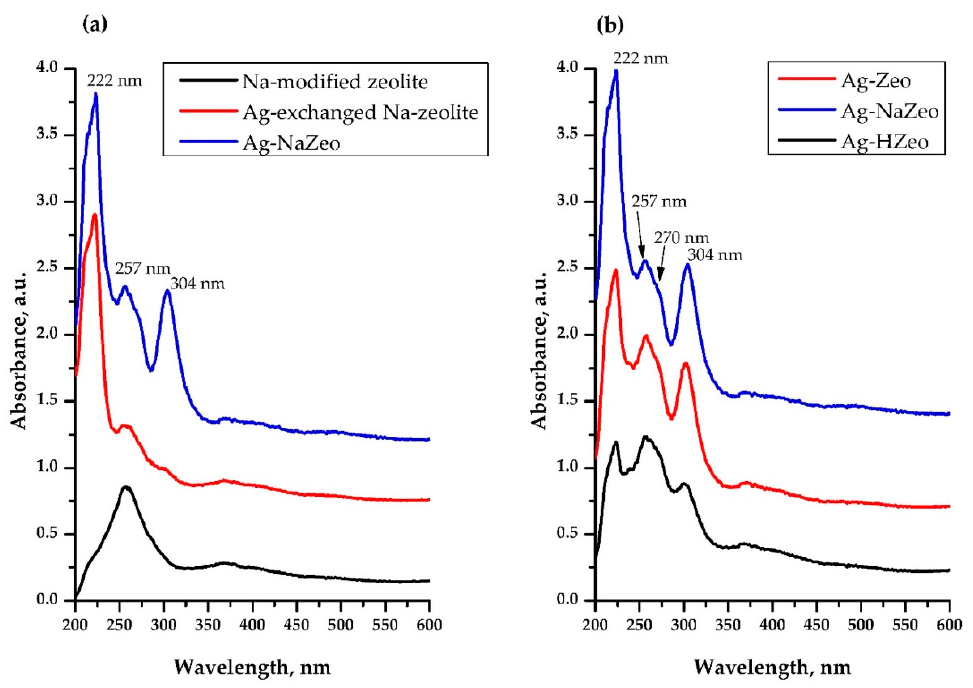
Figure 4. Diffuse Reflectance UV-vis spectra of: ( a ) precursors Na-modified zeolite (black line), Ag–exchanged Na-zeolite (red line), Ag–NaZeo (blue line); ( b ) nanocomposites Ag–HZeo (black line), Ag–Zeo (red line), Ag–NaZeo (blue line).